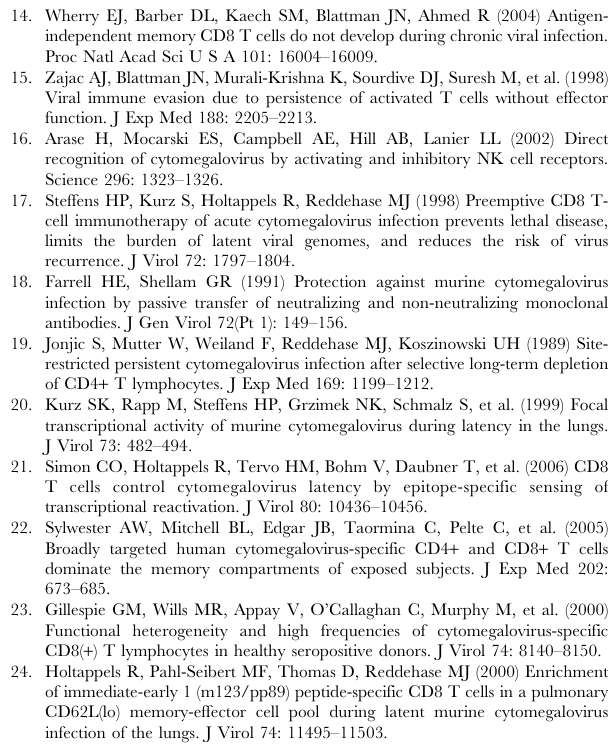
Figure S1 M38-specifc CD8 T cell populations in various lymph nodes. Mediastinal, axillary, cervical and inguinal lymph nodes were pooled from three individual C57BL/6 mice which had been infected with MCMV- D m157 for 80 days. Representative plots showing the percentages of M38- specific CD8 T cells among total lymphocytes are shown for each lymph node (upper plots), and the lower plots show the expression of KLRG-1 and IL7R a on M38-specific CD8 T cells. One of two independent experiments is shown. Figure S2 Phenotype of Mini and Maxi CD8 T cells. 10 5 Mini and 10 4 Maxi CD8 T cells were adoptively transferred into C57BL/6 mice one day prior to infection, and blood samples were collected at the indicated time points after infection with MCMV- D m157. Representative plots showing the expression of CD62L and IL7R a gated on endogenous (CD45.2) and on transferred M38-specific CD8 T cells (CD45.1). Figure S3 Priming of MCMV-specific CD8 T cell responses in DC-MHCI chimeric mice. WT R WT, DC-